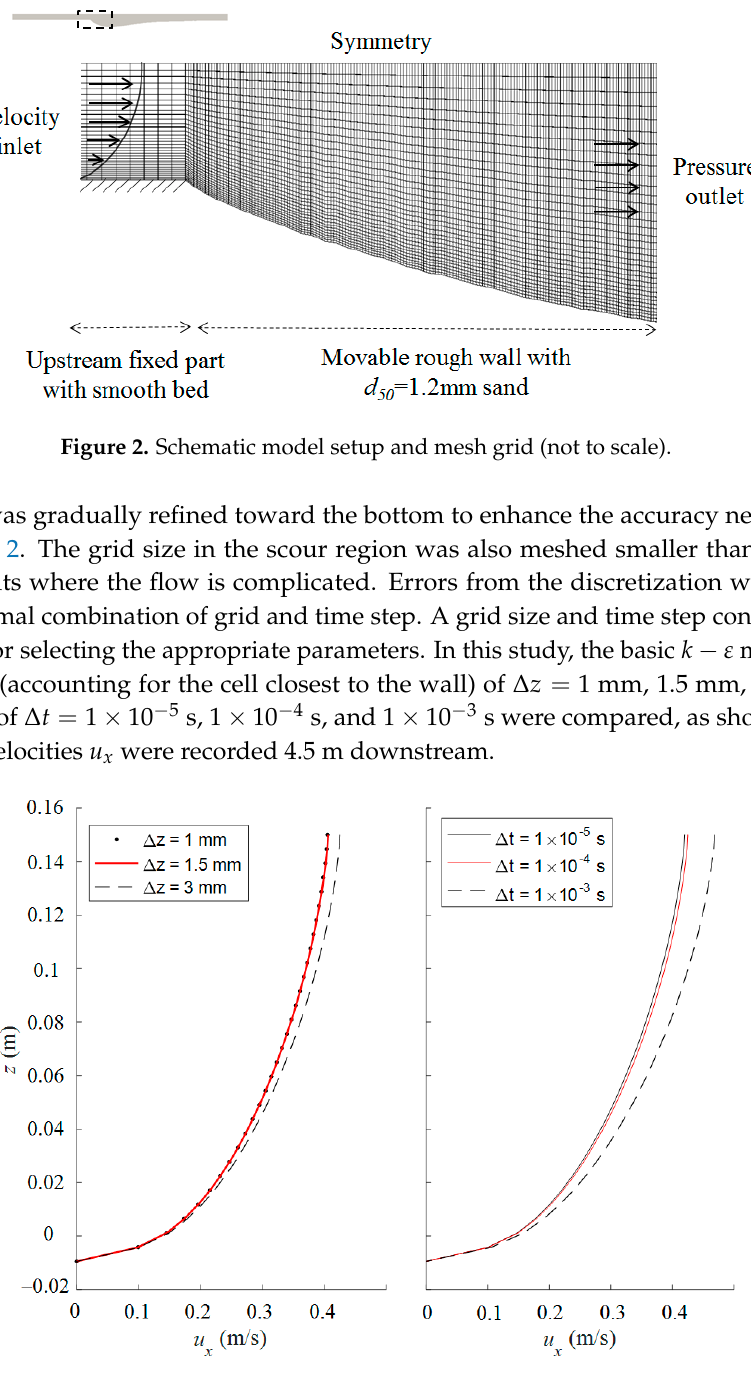
Figure 3. Grid size and time step convergence.